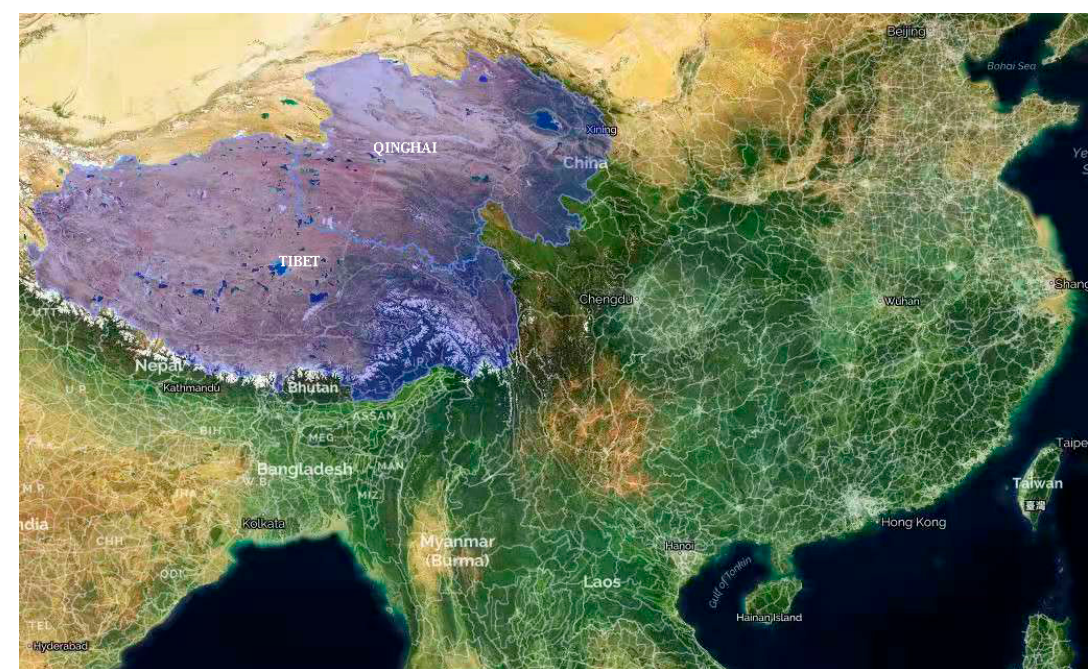
Figure 1. High-altitude western regions of China.